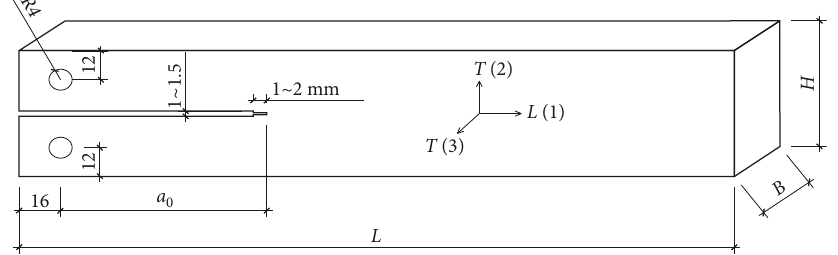
Figure 3: The configurations of DCB specimens. Table 2: Dimensions of DCB specimens.